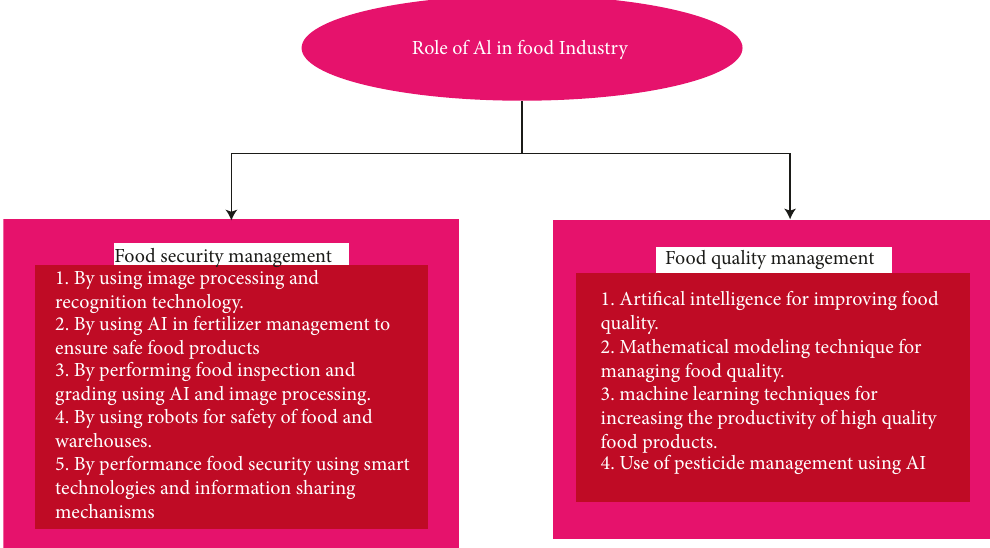
Figure 1: The role of AI in the food